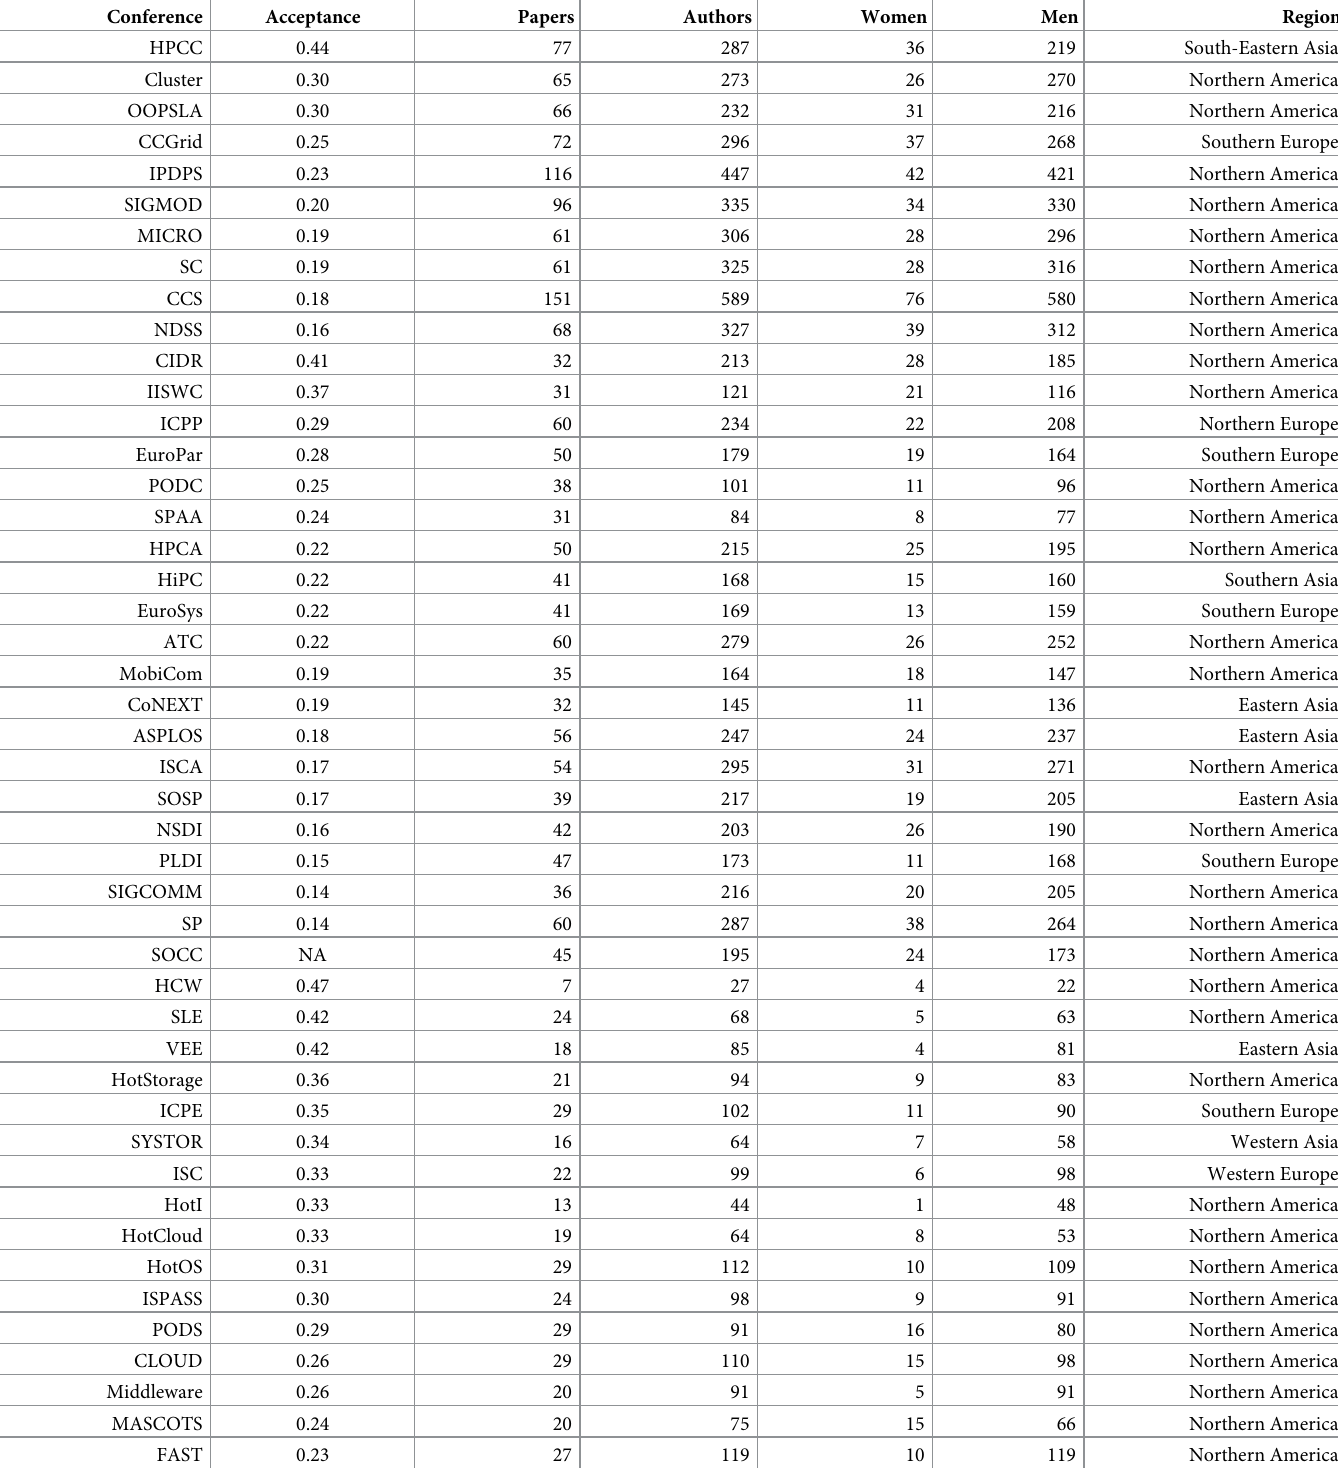
Table 1. System conferences, including acceptance rate, number of accepted papers, number of named authors (total, women, men), and geographical region. Con- ferences are grouped by size (over 60 papers, 31–60, and 30 or under) and sorted by acceptance rate in each group. For SOCC and IGSC, no data on submissions numbers were